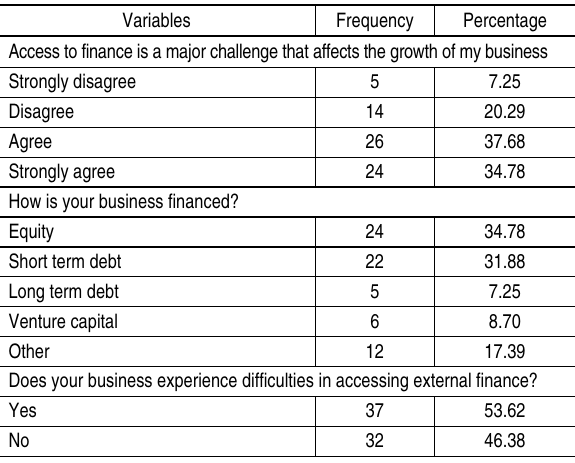
Table 5. Summary of accessing finance by